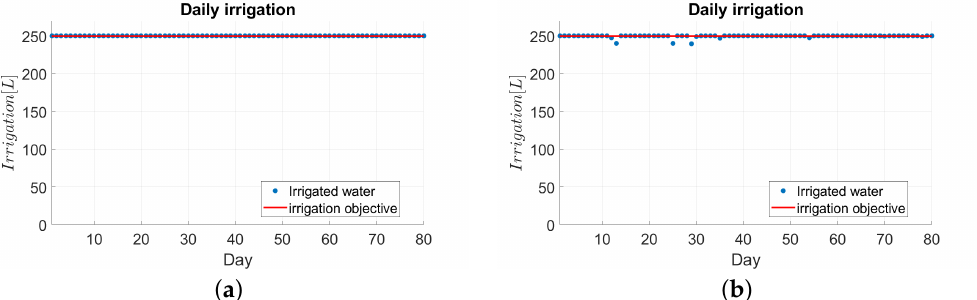
Figure 11. Daily irrigation V r performed during the simulation. This daily irrigation volume, represented by the blue points, was compared with the values denoted by the red line, indicating the daily irrigation objective ¯ V based on medium-term management. ( a ) Daily irrigation V r in the manual irrigation scenario; ( b ) daily irrigation V r in the EMS irrigation